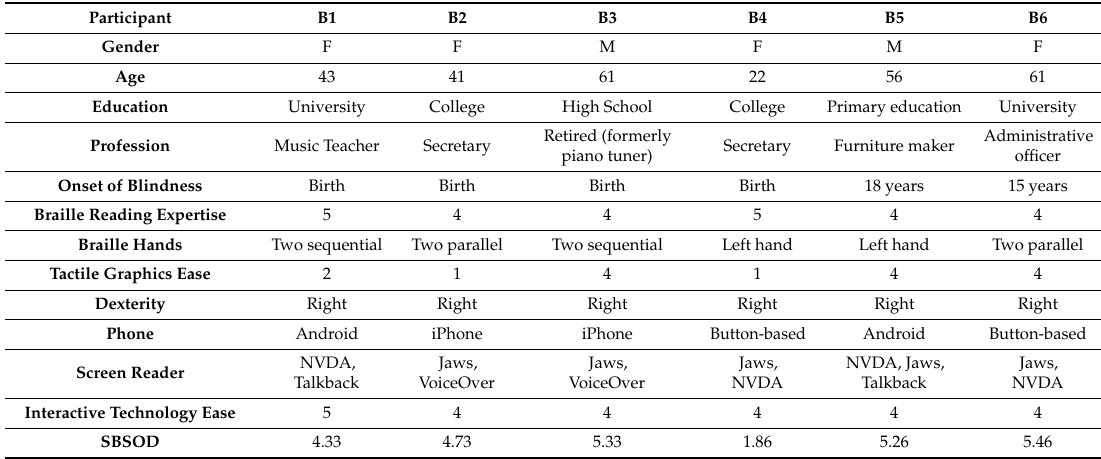
Table 2. Table of blind participants. Likert scale for braille reading expertise, tactile graphics ease